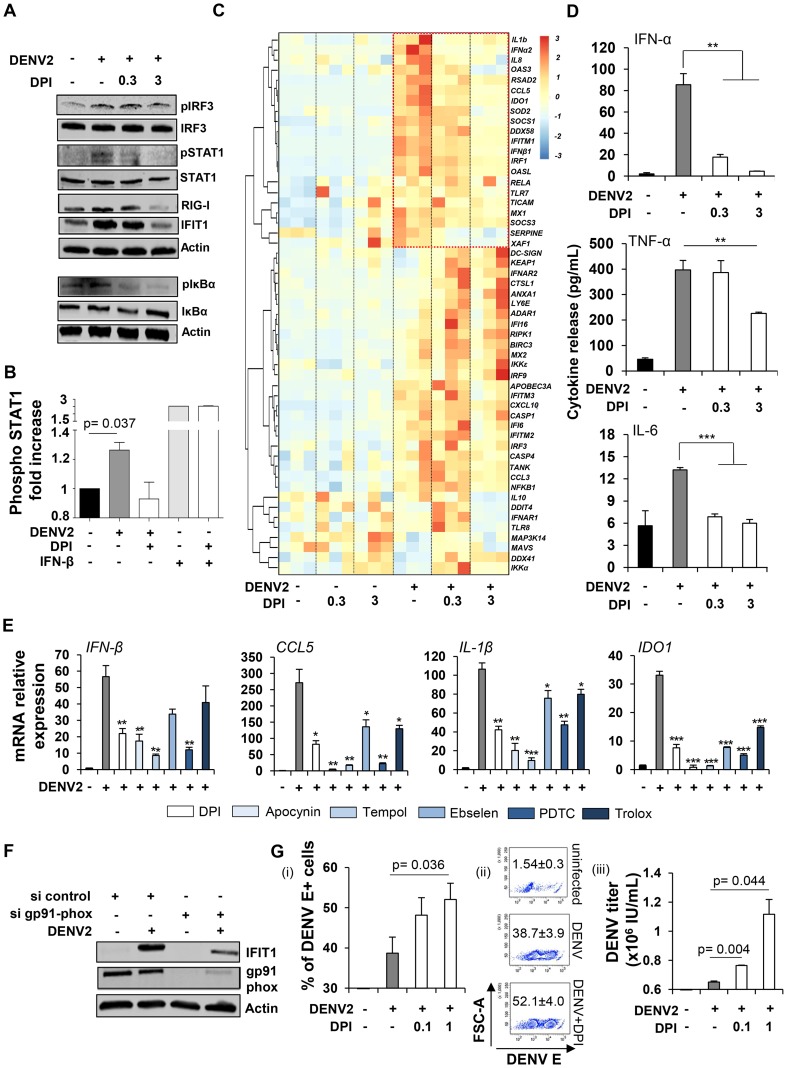
Cellular oxidative stress response is required to mediate DENV-induced innate immune responses.Mo-DC were pre-treated with DPI (0.3 or 3 µM) for 1 h, and subsequently infected with DENV2 (MOI 20) for 24 h. (A) Antiviral and inflammatory responses were monitored by immunoblotting. Data are representative of at least two independent experiments on separate donors. (B) Intracellular levels of phosphorylated STAT1 were detected by PhosFlow in Mo-DC infected for 24 h by DENV2 (MOI 20) or stimulated for 30 min with IFN-β (1000 IU/mL) and pre-treated or not with DPI (1 µM). Data represent the means ± SEM from two experiments performed on separate donors. (C) High throughput analysis of gene expression evaluated by qPCR BioMark analysis. Gene expression levels were calculated using the ΔΔCt method and gene-wise standardized expression (z-score) were generated for each gene. The scale represents z-score values where red shows an up-regulation and blue a down-regulation in gene expression. Data are representative of one experiment performed on three individual donors. Each box of the heatmap represents one donor. (D) Cytokine release was evaluated by cytokine bead array (CBA) on the supernatants of DENV infected cells pre-treated or not with DPI (0.3–3 µM). Data represent the means ± SEM from three individual donors. P values were determined based on the comparison with DENV2-infected cells. (E) Mo-DC were pre-treated with DPI (3 µM), Apocynin (3 mM), TEMPOL (3 mM), Ebselen (10 µM), PDTC (40 µM) and Trolox (5 µM) for 1 h, and subsequently infected with DENV2 (MOI 20) for 24 h. Antiviral and inflammatory gene expression was determined by qPCR. Data represent the means ± SEM from one experiment performed on three individual donors. P values were determined based on the comparison with DENV2-infected cells. (F) Mo-DC were transfected with control or gp91 phox siRNA and 48 h later were infected with DENV2 (MOI 20). IFIT1 and gp91 phox protein expression levels were measured by immunoblot analysis. Result is representative of one experiment. (G) Mo-DC were pre-treated with DPI (0.1–1 µM) for 1 h, and subsequently infected with DENV2 (MOI 1) for 48 h. Percentage of infected cells was determined by intracellular staining of DENV E protein (i–ii). DENV titers were determined by transferring supernatants from Mo-DC-infected cells on A549 cells and staining for DENV E protein (iii). DENV titers were expressed as the number of infectious units/mL. Data represent the means ± SEM of experiments performed on four (i–ii) and two different donors (iii).